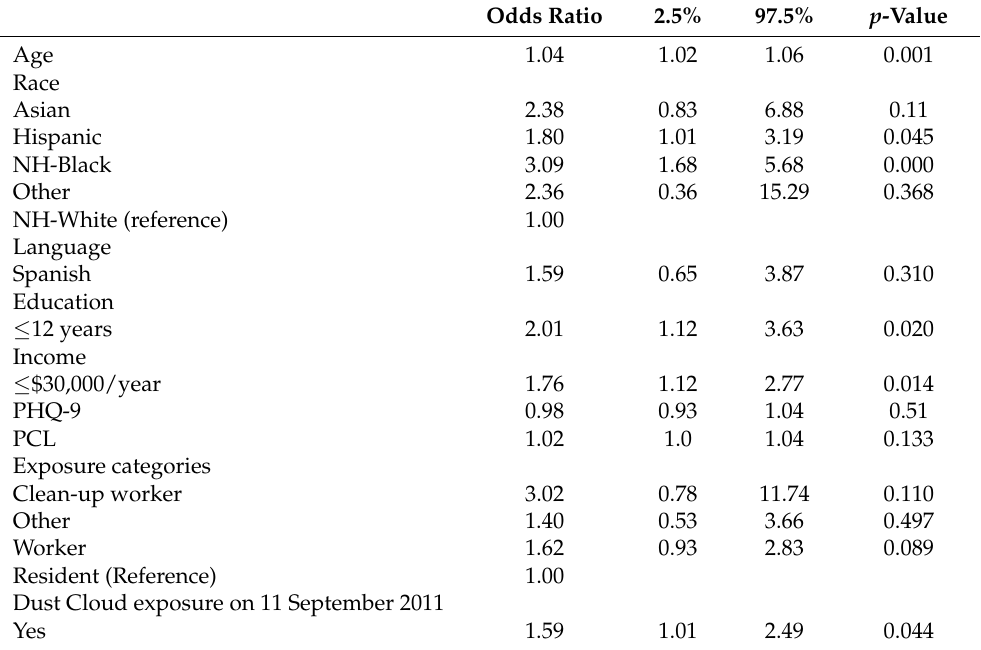
Table 3. Multivariable logistic regression on status of MoCA <